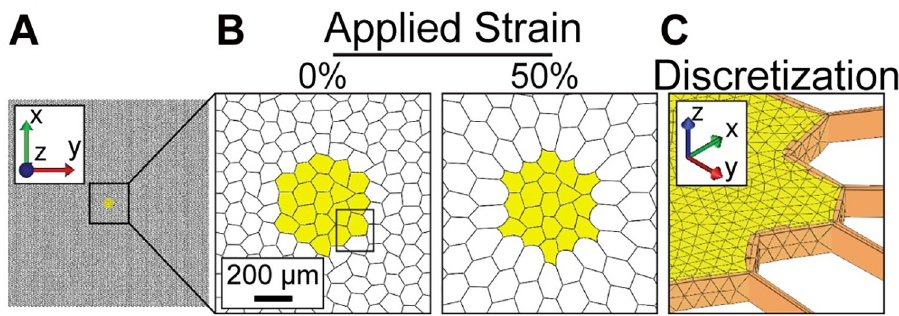
Fig 2. Implementation of a geometric tissue-scale constitutive model of lung cancer. A. Lung model, in which alveoli are represented as shell elements organized in a randomized hexagonal lattice. Model is 9,885 μ m x 10,000 μ m x 30 μ m. B. Zoomed-in view of tumor and adjacent matrix under 0% and 50% globally applied stretch in x and y, displacement in z is fixed. C. Discretization of the lung model. Alveoli are represented by shell elements. The tumor is discretized using tetrahedral elements with a surrounding basement membrane of triangular